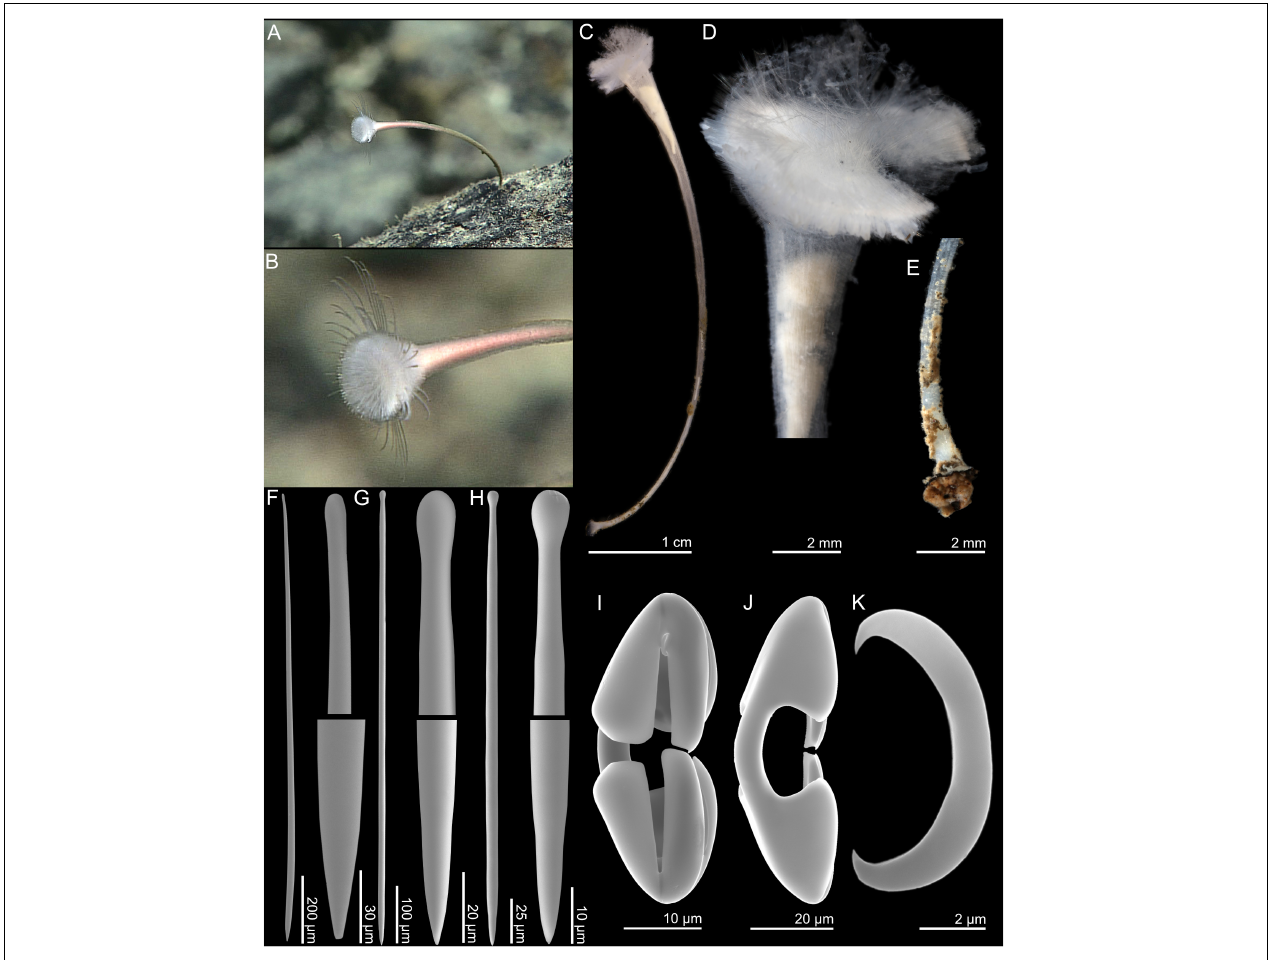
FIGURE 6 | Abyssocladia villosa n. sp. (A,B) In situ images from ROV feed, (C) whole specimen, (D) detail of body, (E) detail of basal plate, (F) subtylostyle, (G) tylostyle I, (H) tylostyle II, (I) cleistochela front view, (J) cleistochela back view, and (K) sigmancistra.